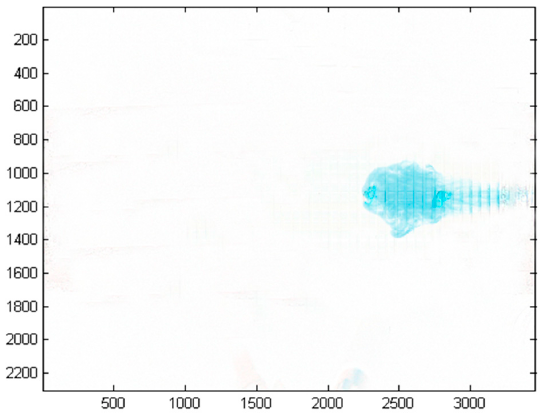
Figure 2. Difference in value between the adjusted image and the background image.